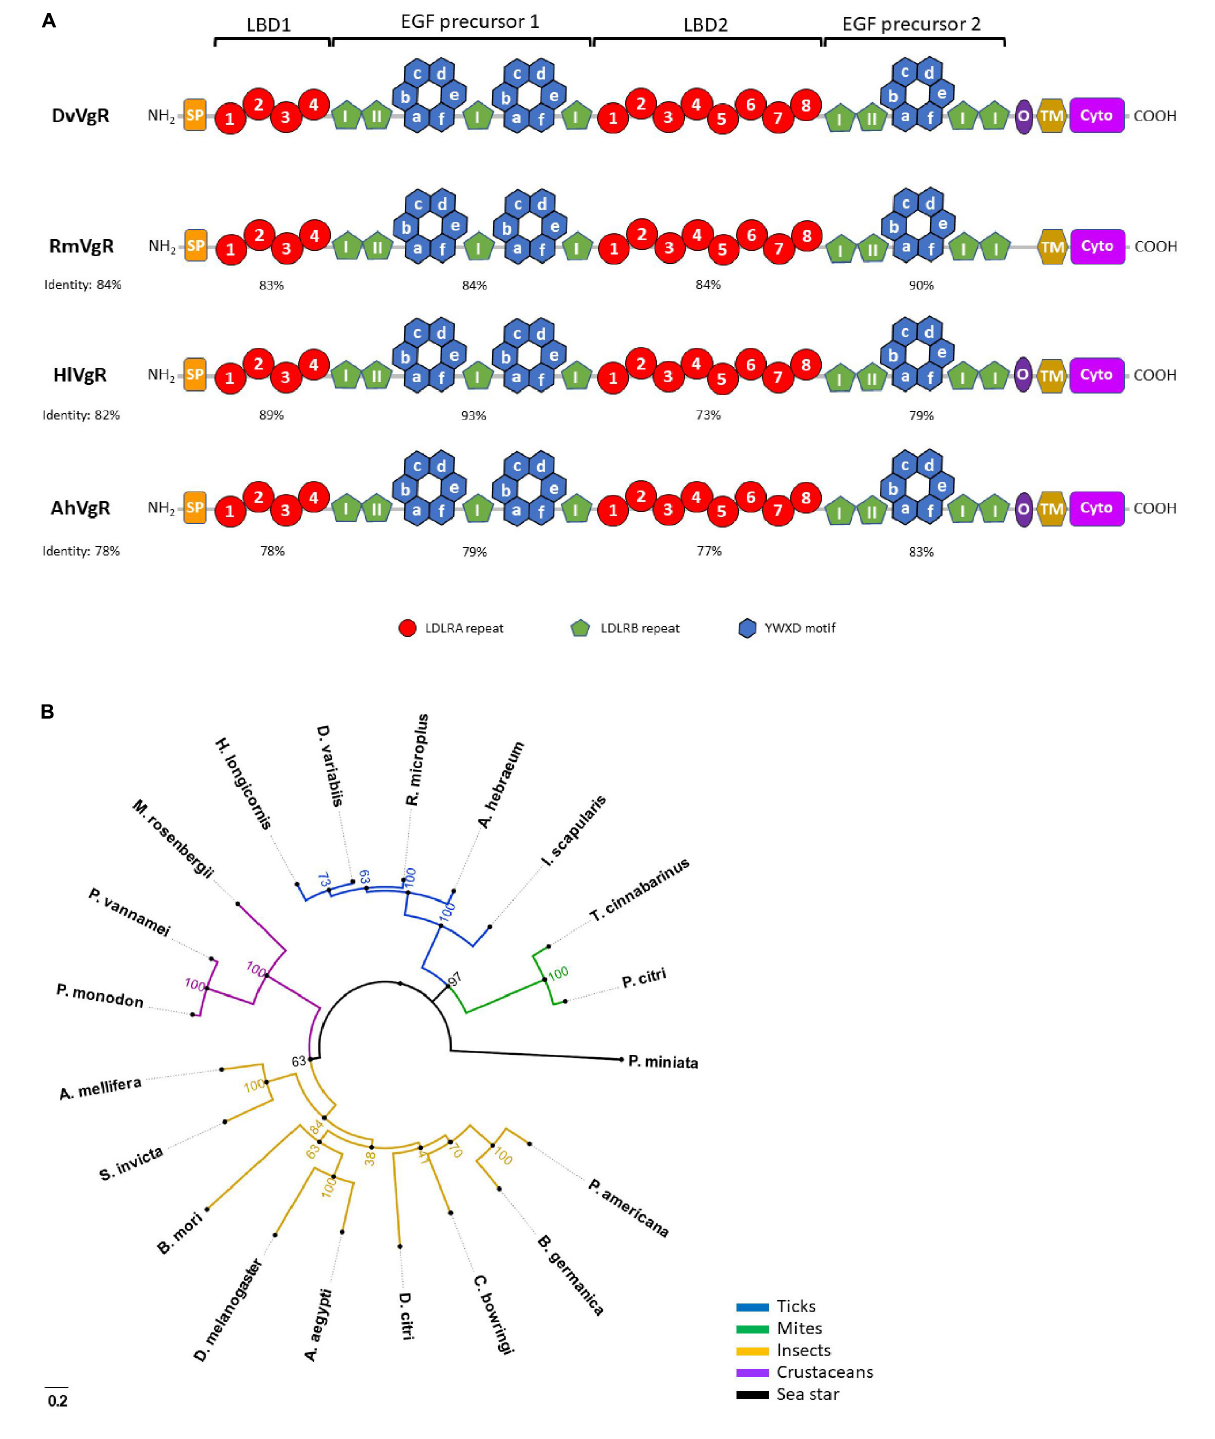
FIGURE 1 | Tick vitellogenin receptor (VgR) structure and phylogeny in relation to VgRs from other organisms. (A) Tick VgRs from D. variabilis (DvVgR), R. microplus (RmVgR), H. longicornis (HlVgR), and A. hebraeum (AhVgR). Percentages under the species identifier represent the percent identity of that species with the full-length VgR amino acid sequence of D. variabilis . Percentages under the four highlighted domains represent the percent identity of that region in relation to the D. variabilis VgR amino acid sequence. LBD1, ligand-binding domain 1; EGF precursor 1, epidermal growth factor (EGF)-precursor homology domain 1; LBD2, ligand-binding domain 2; EGF precursor 2, epidermal growth factor (EGF)-precursor homology domain 2; “I” inside green pentagon, EGF-like repeat within LDLRB repeat of LBD (non-calcium binding); “II” inside green pentagon, EGF-like repeat within LDLRB repeat of LBD (calcium binding); SP, signal peptide;